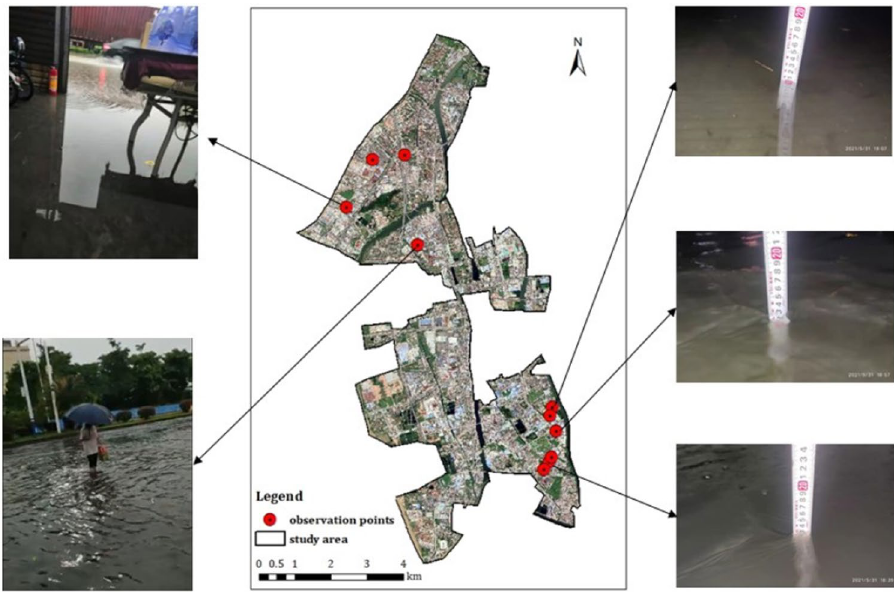
Figure 16. Measurement points and photos of flooding in the case area. This map was generated with ArcMap Version 10.0. (https:// www. esri. com/ en- us/ arcgis/ produ cts/ arcgis- deskt op/ overv